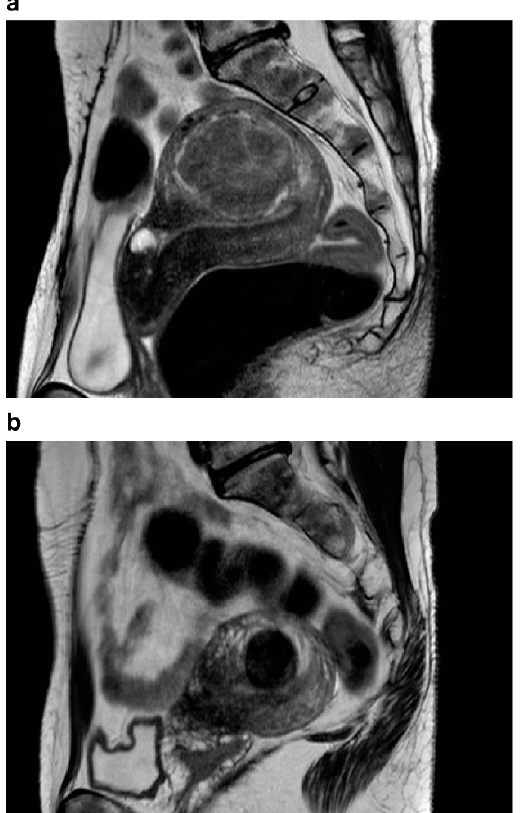
Figure 1. T2-weighted images of pelvic MRI (sagittal plane): ( a ) before surgery; ( b ) 3 months after surgery. The myoma volume was reduced from 65 mm (before surgery) to 27 mm (3 months after surgery).